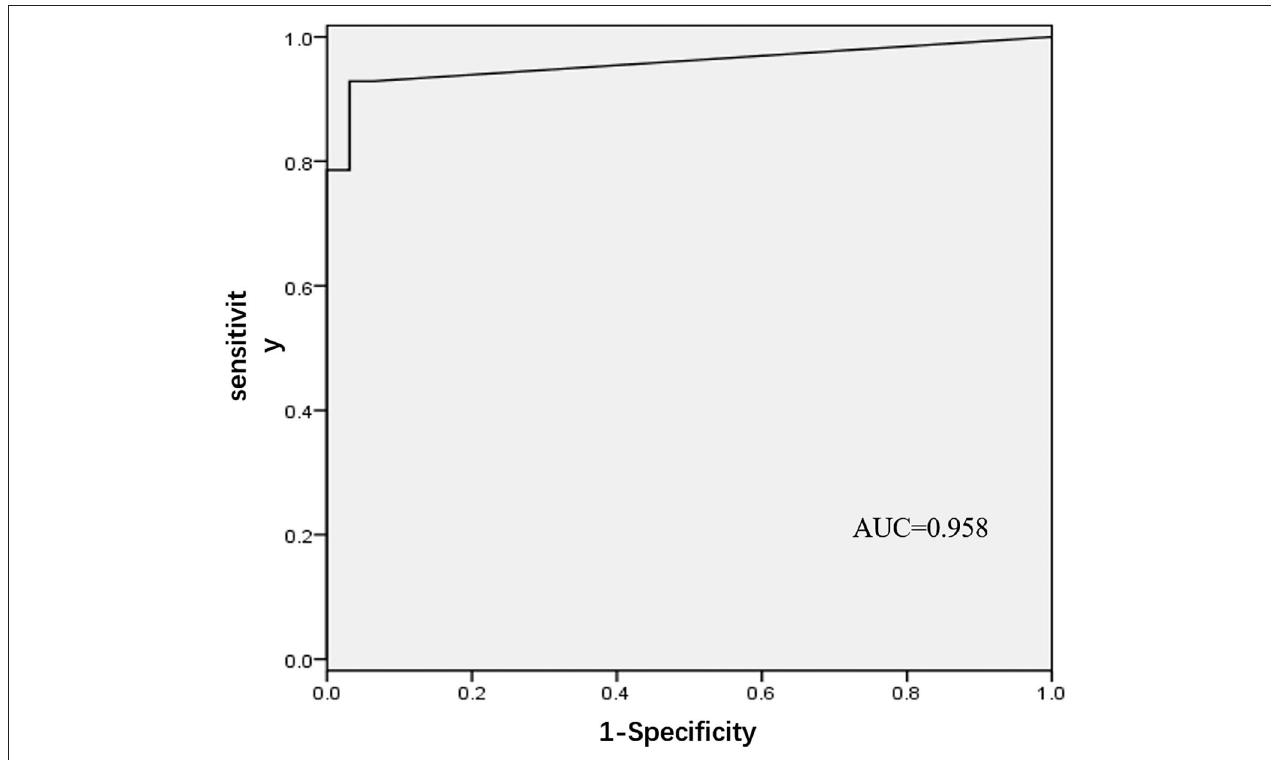
FIGURE 2 | Receiver operating characteristic (ROC) analysis for different intervals between far-field atrial potential and pulmonary vein potential.